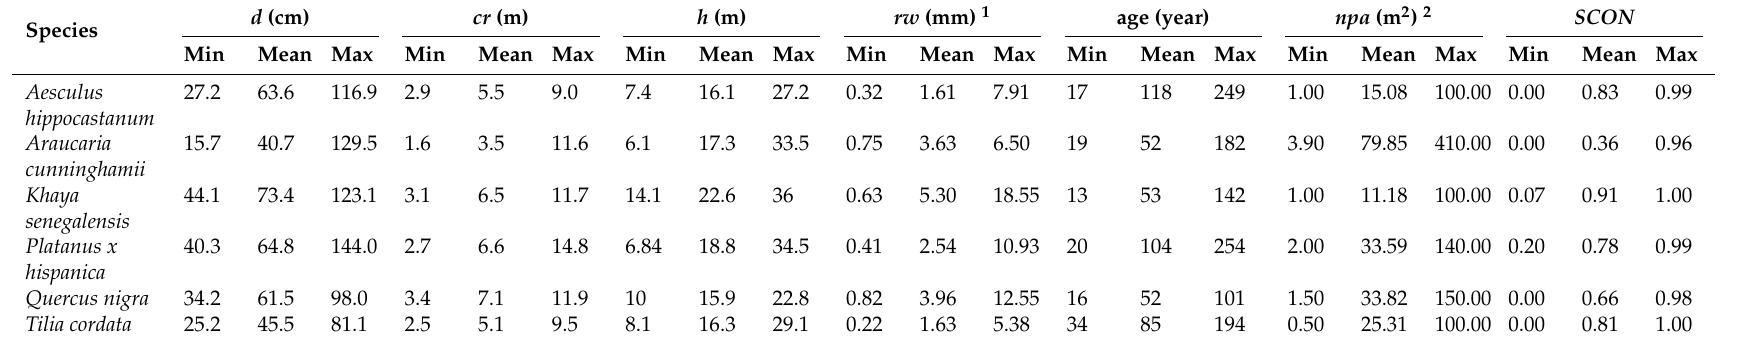
Table 2. Tree characteristics for each